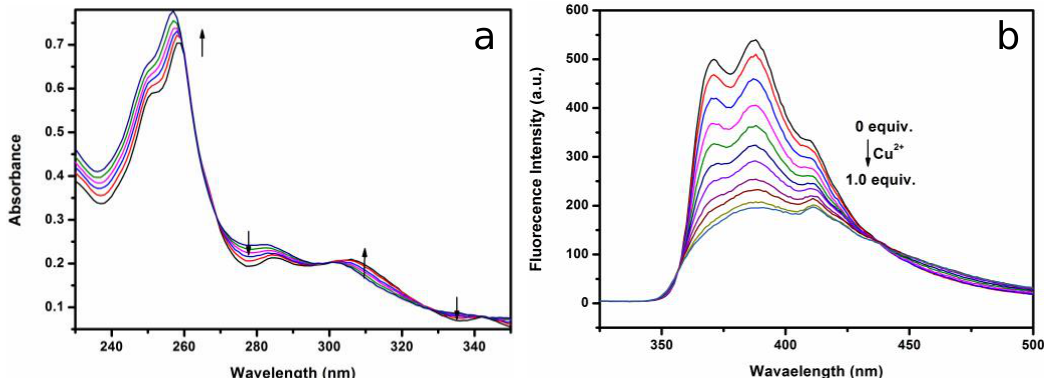
Figure 1. UV/vis absorption ( a ) and fluorescence ( b ) spectra of Probe 1 in ethanol (10 μM) upon addition of varying concentrations of Cu 2+ ions (0–1 equiv).